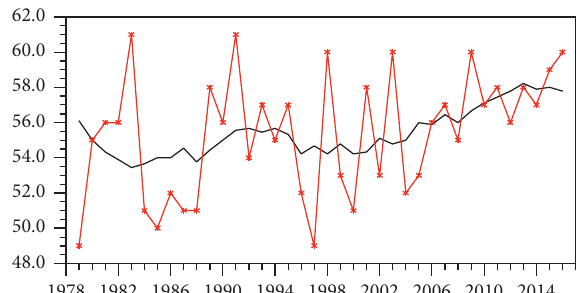
Figure 5: The pentad of the SCSSM withdrawal dates (red line). The black lines denote the 5-year running average.